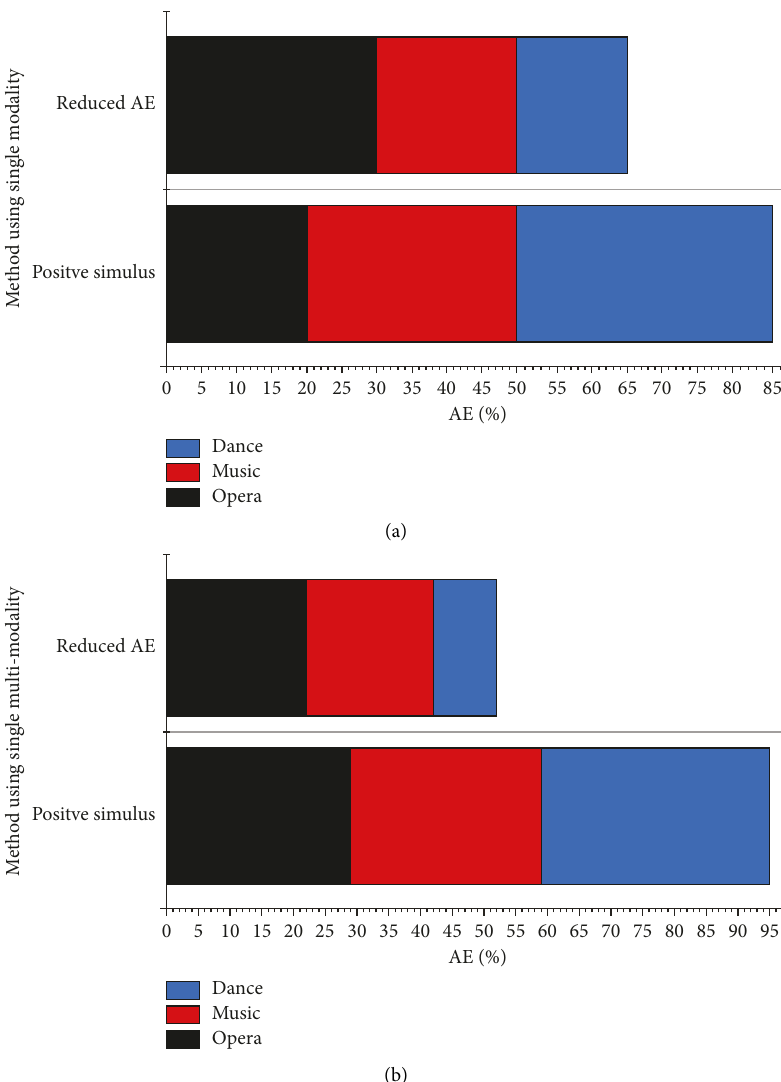
Figure 6: (a) AE evaluation analysis for a single modality using dance, music, and opera. (b) AE evaluation analysis for multimodality using dance, music, and